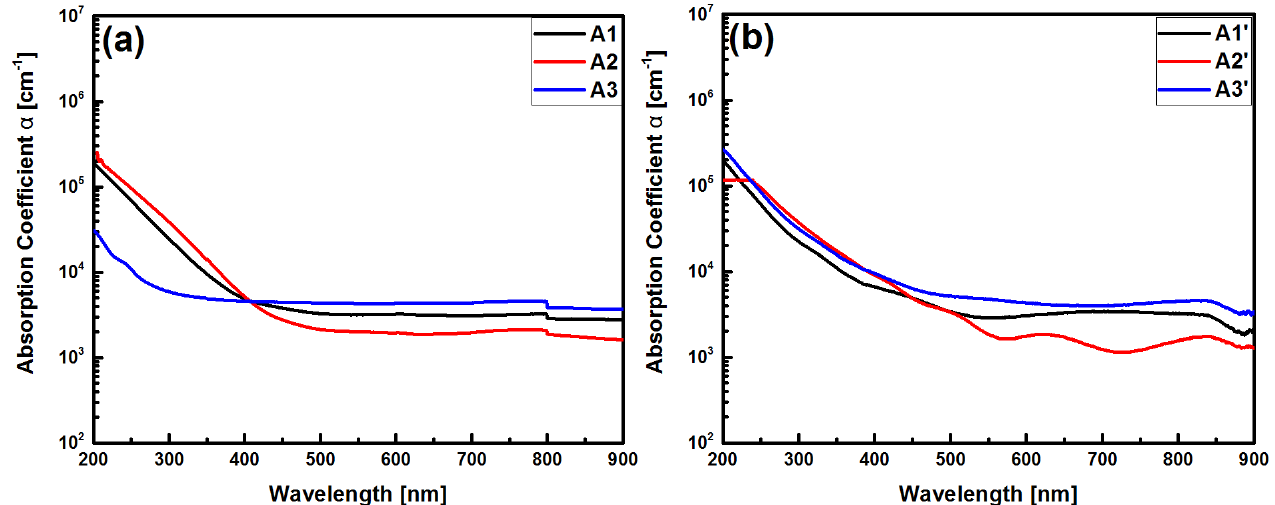
Figure 4. Absorption coefficients of SRO films without ( a ) and with thermal annealing ( b ). The optical band gap is obtained by Tauc’s law [21], assuming ((cid:2009)ℎ(cid:2021)) (cid:1827)(cid:3435)ℎ(cid:2021) − (cid:1831) (cid:3439) , where α is the absorption coefficient, ( hv ) is the energy of the photon, E g is the (cid:3034)